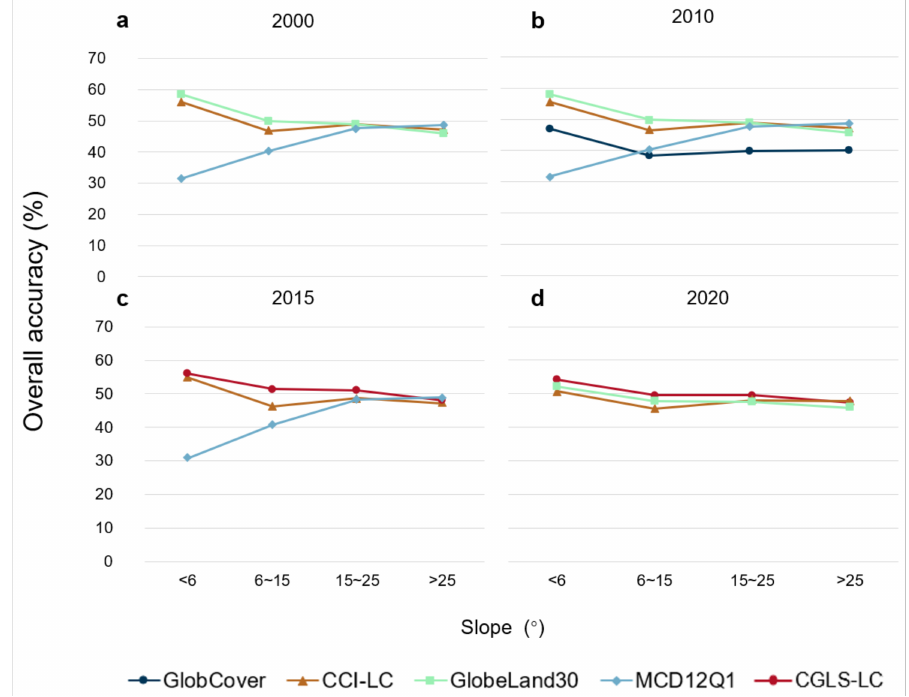
Figure 10. Overall accuracy of land cover datasets with different slope levels for epochs ( a ) 2000, ( b ) 2010, ( c ) 2015, and ( d ) 2020.